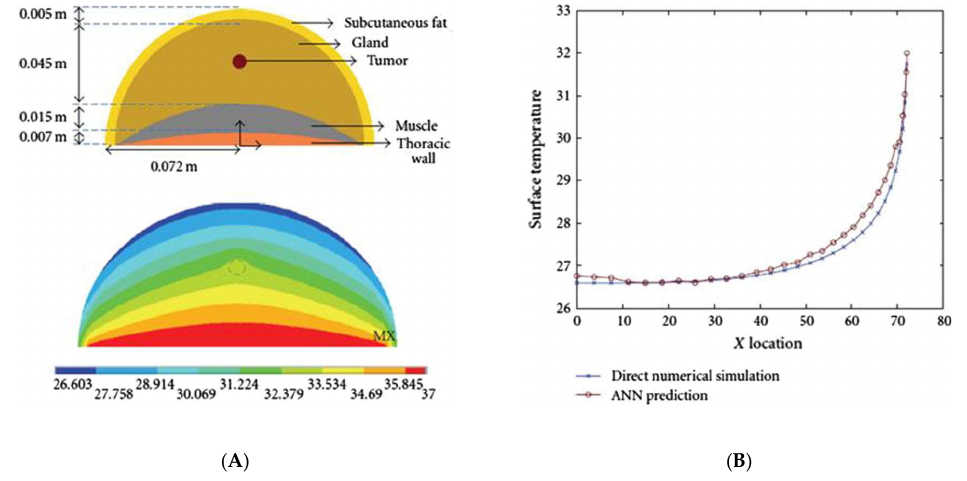
Figure 2. Illustration of thermal diffusion in a conventional breast representation [22]. ( A ) The computational domain as a hemisphere semi-spherical. ( B ) Numerical simulation and surface temperatures.